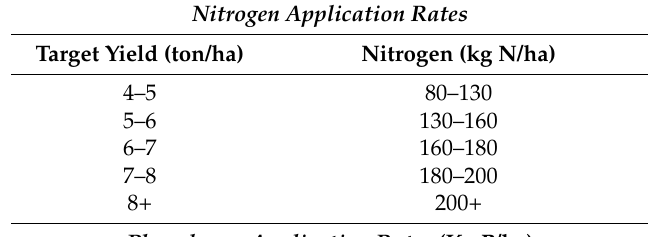
Table 2. Nitrogen (Kg N/ha) and phosphorus fertilization (Kg P/ha) based on targeted yield under irrigation.